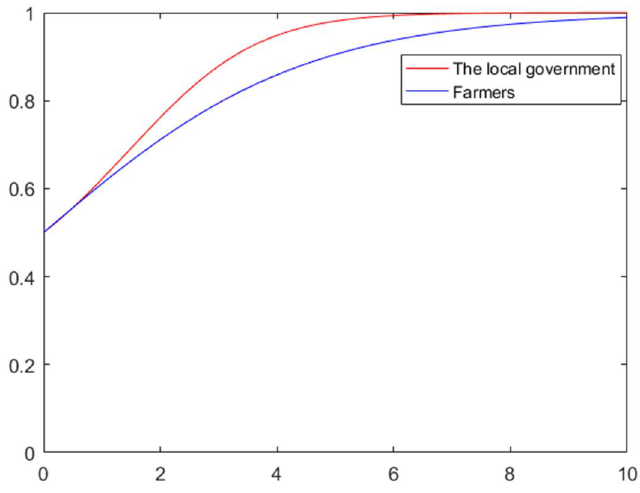
Figure 12. Simulation results at the fourth stage (I 2 = 3, I 4 = 3, ∆ S 2 = 1.5 ).